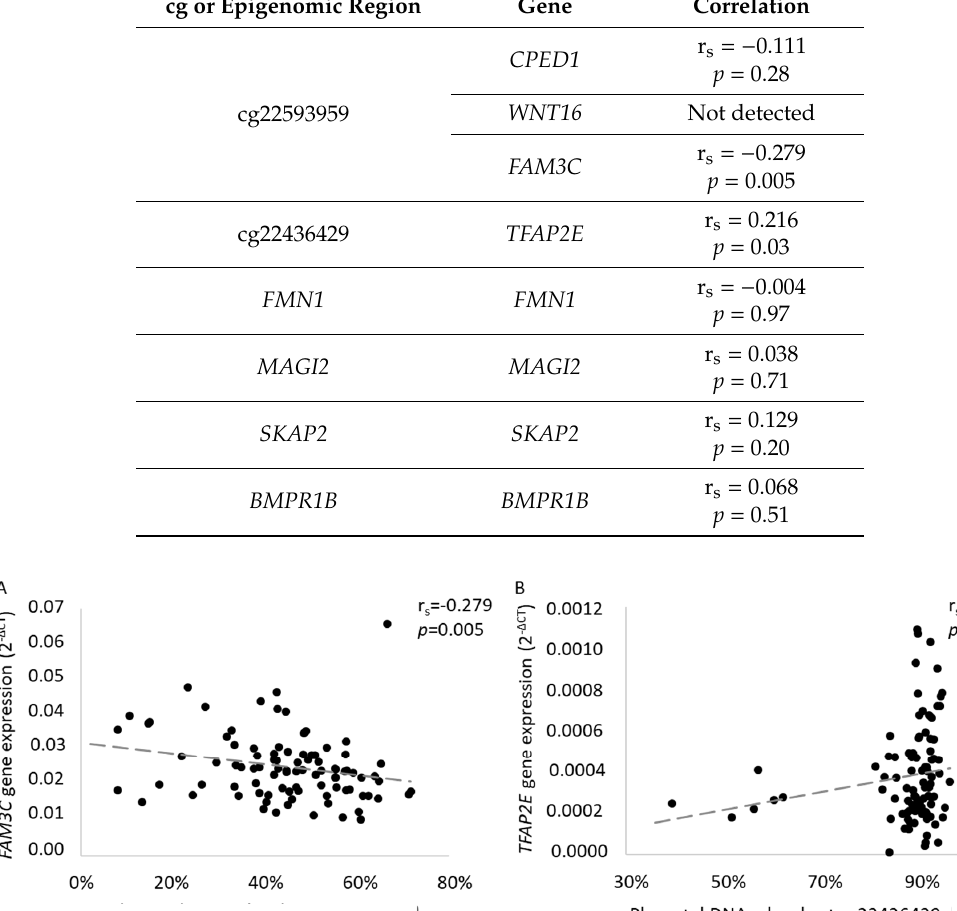
Table 4. Association between DNAm levels at both single-site and epigenomic regions, and transcriptional activity.